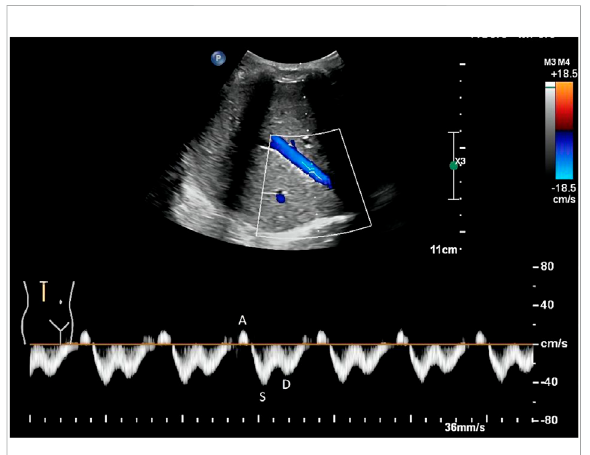
Normal hepatic vein fl ow pattern detected by Doppler. The hepatic vein has atriphasicwaveform, which consists of an A wave above the baseline (representing atrial systole), and two waveforms below the baseline (S and D, representing venous return during ventricular systole and diastole,